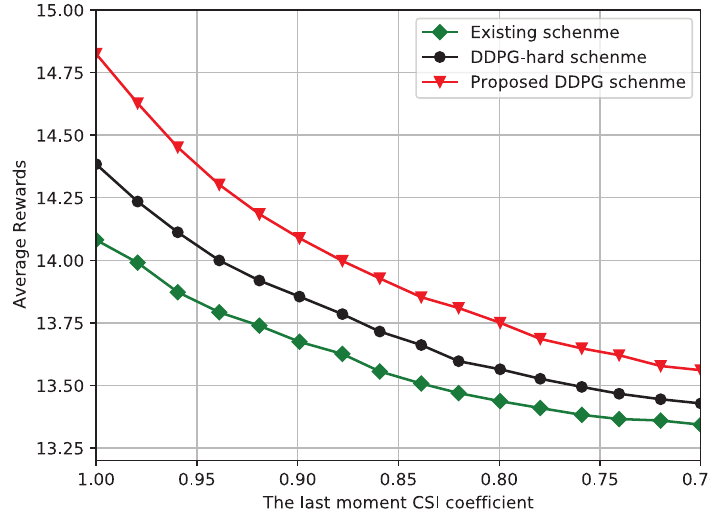
Figure 5. Average reward against the last moment CSI